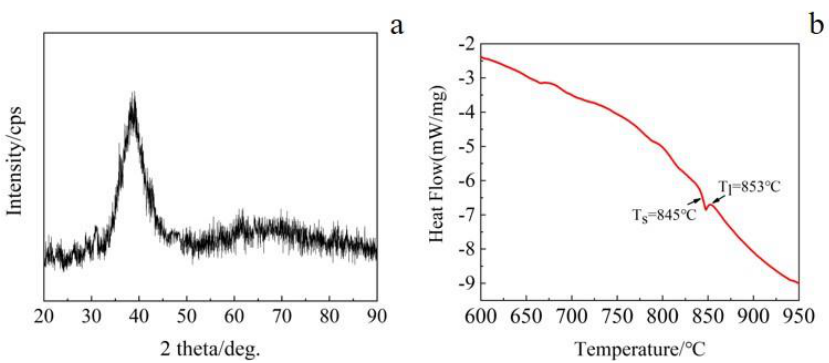
Figure 1. ( a ) XRD pattern and ( b ) DSC curve of Ti35.5Zr38.65Cu15.70Ni10.10 (wt.%) amorphous filler alloy.